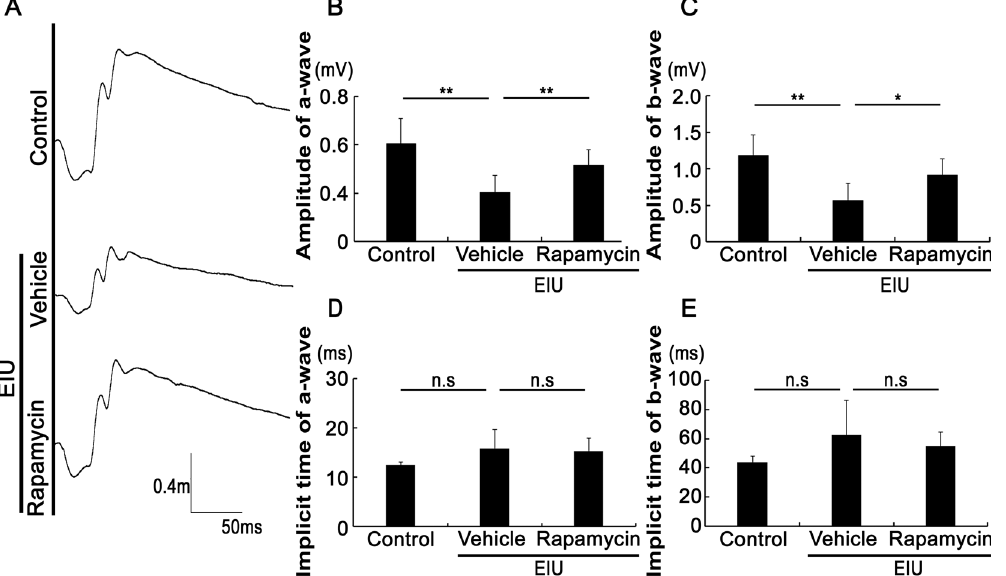
Fig 2. Rapamycin suppressed visual function impairment during inflammation. Representative waveforms of an individual mouse recorded by electroretinography 24 hours after the induction of inflammation by an intraperitoneal injection of lipopolysaccharide (LPS) (A). The amplitudes of both the a- wave (B) and b-wave (C) were reduced during inflammation, and were attenuated by the rapamycin treatment. The implicit times of the a-wave (D) and the b- wave (E) were not changed; n = 6. * p < 0.05, ** p < 0.01.